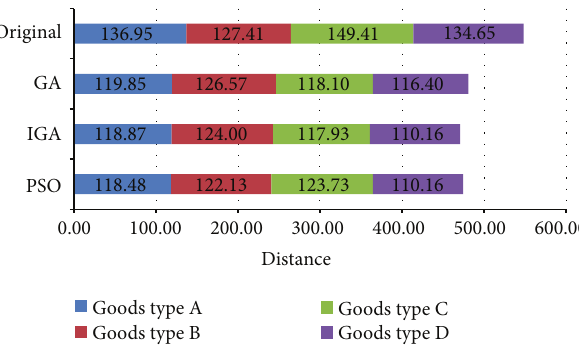
Figure 13: The Gantt chart for different travelled distances under Case 1.